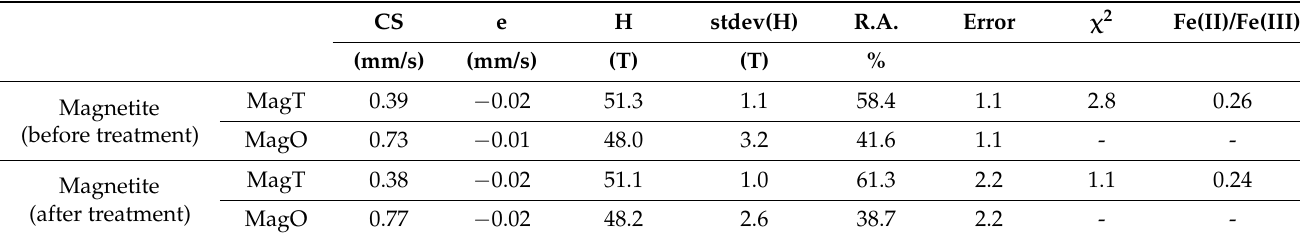
Table 3. Fitting results of Mössbauer spectroscopy. CS—center shift. e—quadrupole shift. H—hyperfine field.